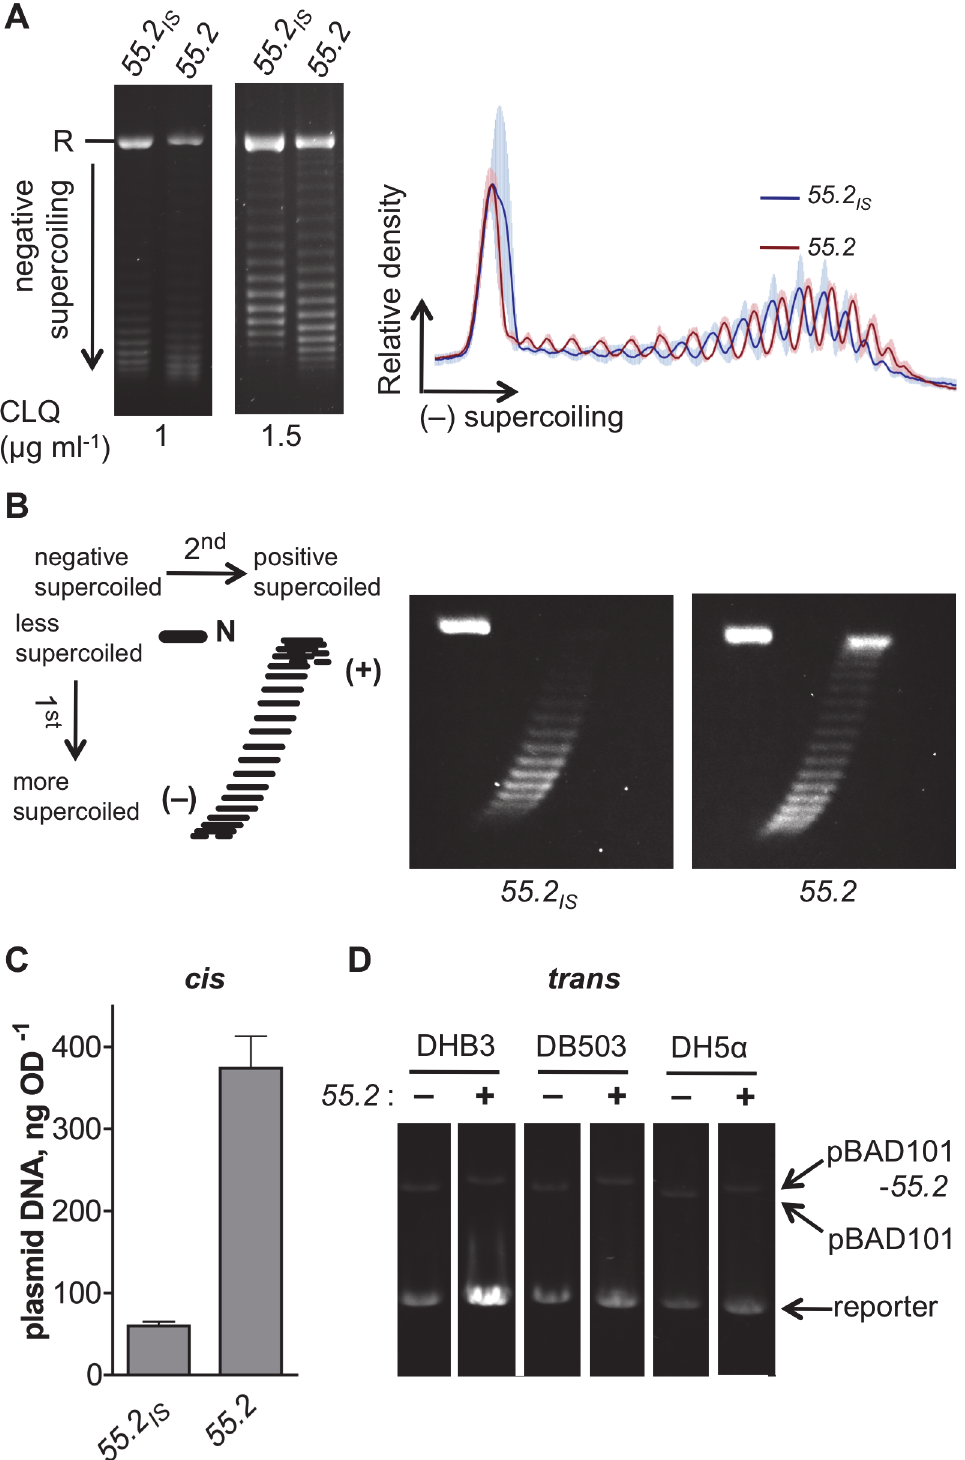
Fig 4. 55 . 2 expression affects the control of DNA topology and plasmid copy number in E . coli . (A) Plasmid topoisomers analysis. Left panel: plasmid DNA was extracted from exponentially growing DH5 α harboring pYM58 ( 55 . 2 IS ) or pDB2114 ( 55 . 2 ) plasmids. Plasmid topoisomers were resolved on TBE agarose gels containing the indicated amount of CLQ. The position of migration of relaxed and/or nicked circular DNA is indicated (R). Right panel: Densitometry analysis of the topoisomer distribution on 1.5 μ g ml -1 CLQ gel of four independent samples of pYM58 or pDB2114 plasmid DNA (gel images